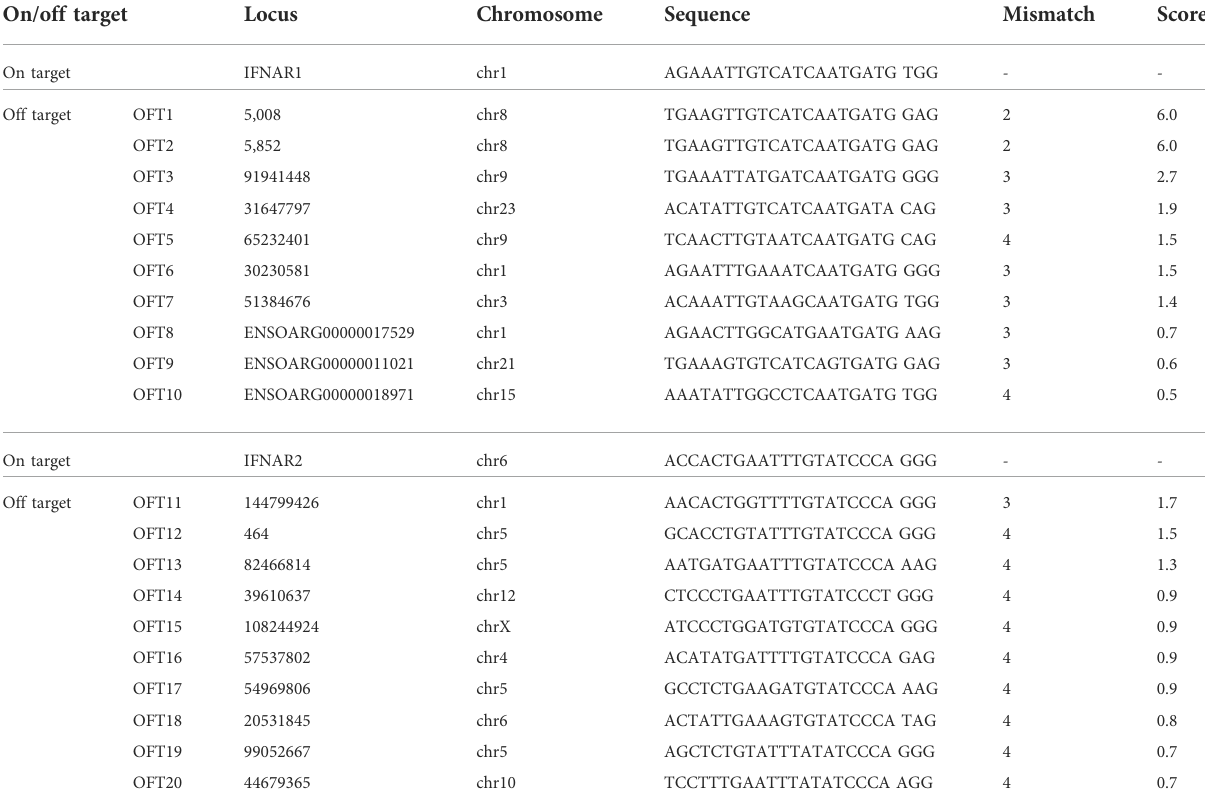
TABLE 5 Potential off-target sites for IFNAR1 and IFNAR2 targeting vectors. On/off